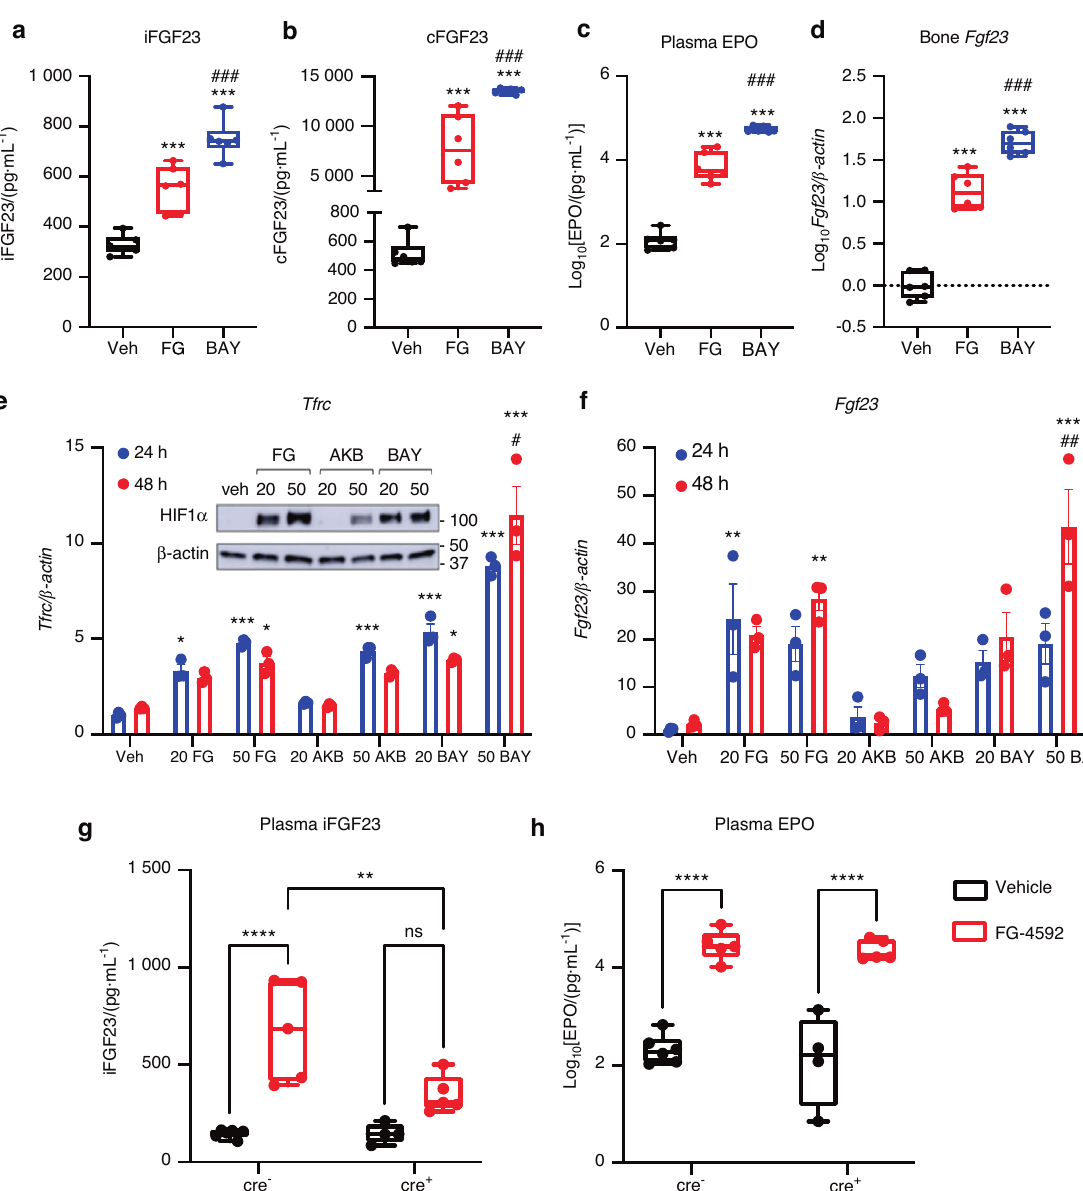
Fig. 1 HIF-PHI induce FGF23 in WT mice and murine osteocyte-like cells. Wild type mice (females) were injected with vehicle (PEG300/DMSO) or 50 mg·kg − 1 of either FG-4592 ( ‘ FG ’ , Roxadustat; red) or BAY 85-3934 ( ‘ BAY ’ , Molidustat; blue) every other day for 5 days, for a total of 3 injections. a Plasma intact FGF23 and b C -terminal/total FGF23 concentrations at 4 hours after fi nal injection. c Plasma erythropoietin (EPO) concentrations and d cortical bone ( fl ushed of marrow) Fgf23 mRNA expression at the end of the study ( n = 6 mice per group; *** P < 0.001 versus vehicle, ### P < 0.001 versus FG treatment). e Transferrin receptor ( Tfrc ) and f Fgf23 mRNA expression in 2-week differentiated MPC2 cells treated for 24 h (blue) or 48 h (red) with 20 μ mol·L − 1 or 50 μ mol·L − 1 of the HIF-PHI FG-4592 ( ‘ FG ’ ; Roxadustat), AKB-6548 ( ‘ AKB ’ ; Vadadustat), or BAY 85-3934 ( ‘ BAY ’ ; Molidustat) (* P < 0.05, ** P < 0.01, *** P < 0.001 versus vehicle; # P < 0.05, ## P < 0.01 24 h versus 48 h). ( e , inset) HIF1 α protein expression in MPC2 cells after 4 h of 20 μ mol·L − 1 or 50 μ mol·L − 1 HIF-PHI treatment. Flox- Fgf23 / Dmp1 -cre + and cre − mice were injected with vehicle (black) or 70 mg·kg − 1 FG-4592 (red) every other day for 5 days, for a total of 3 injections. Plasma concentrations of g intact FGF23 and h EPO were measured 4 hours after fi nal injection ( n = 4 – 6 mice per group; ** P < 0.01, **** P < 0.000